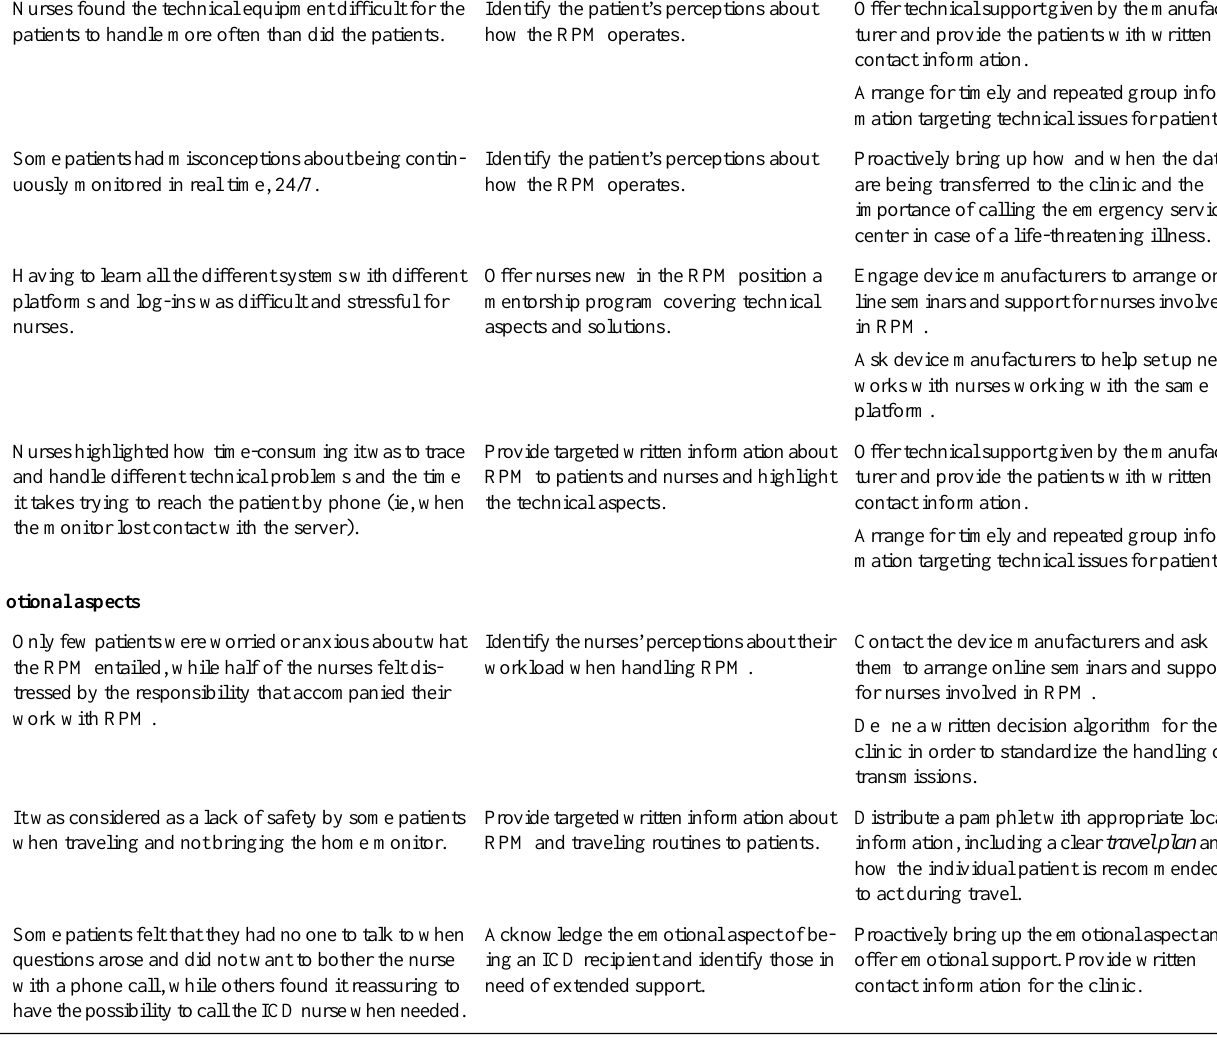
Needed interventions for changed practiceClinical implicationsWeighted